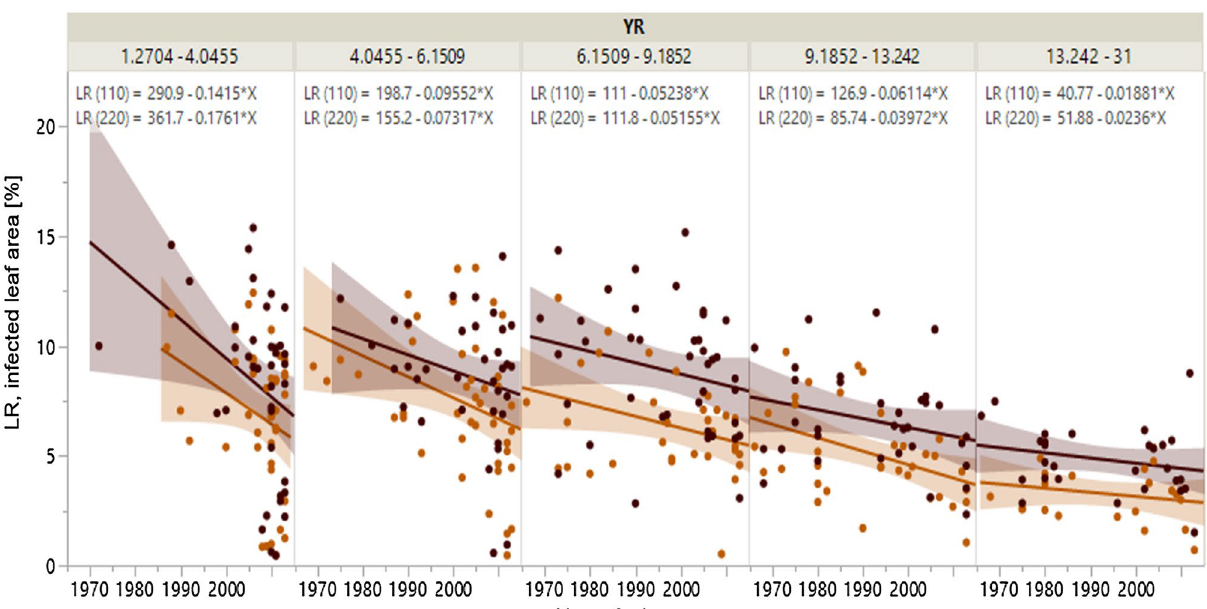
Figure 4. Breeding progress in German wheat against leaf rust. Development of susceptibility of 178 winter wheat cultivars to leaf rust (LR) depending from stripe rust (YR) infestation across 50 years at two N rates (treatments without plant protection) based on LSmeans (treatment-specific, over years and repeats). LR infestation of each YR class is given with linear trend lines of low N (110 kg N ha-1, light brown) and high N input (220 kg N ha −1 , dark brown), each with 95% confidence interval. Equations of all trendlines are given above each